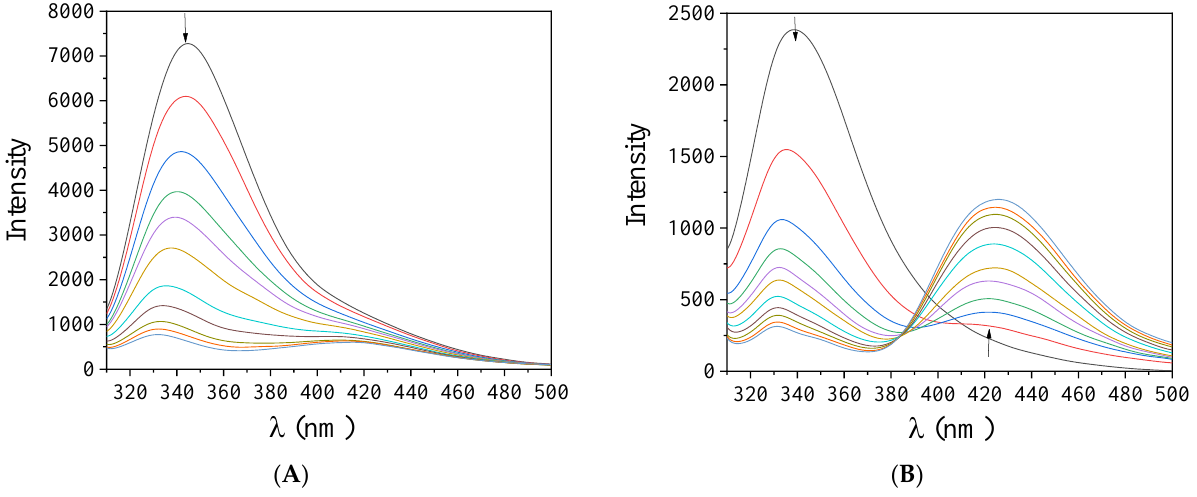
Figure 5. Fluorescence emission spectra (λ excitation = 295 nm) of a buffer solution (150 mM NaCl and 15 mM trisodium citrate at pH 7.0) containing ( A ) BSA (3 μM) upon addition of increasing amounts of complex 2 , and ( B ) HSA (3 μM) upon addition of increasing amounts of complex 3 . The arrows show the changes in intensity upon increasing amounts of the complex. Table 5. The quenching of the SA-fluorescence ( ΔΙ/Ιο, %) and the BSA- and HSA-quenching (k q , M − 1 s − 1 ) and binding (K, M − 1 ) constants for X-saloH and complexes 1 – 5 .